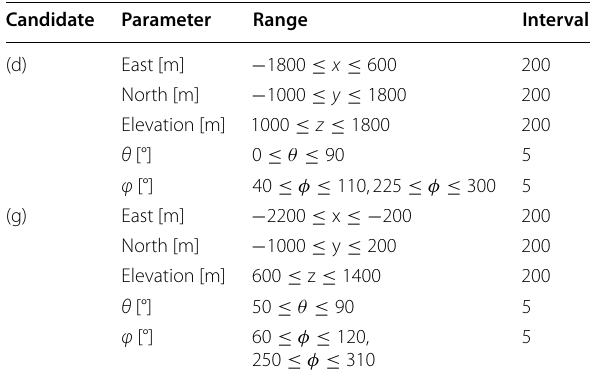
Table 3 Conditions of the second search for candidates (d) and